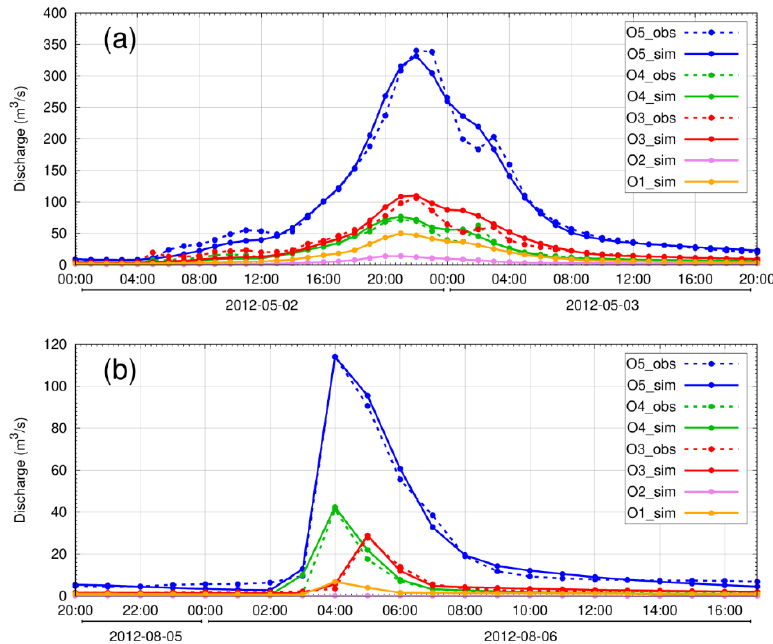
Figure 5. Time series profile of observed (Obs) and simulated (Sim) discharge at sub-basin outlets for the events of ( a ) 2–3 May 2012 (widespread rain, WR) and ( b ) 5–6 August 2012 (convective rain, CR).